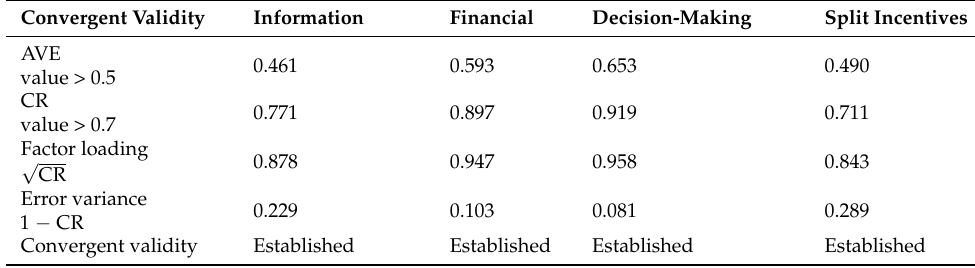
Table 6. Convergent validity